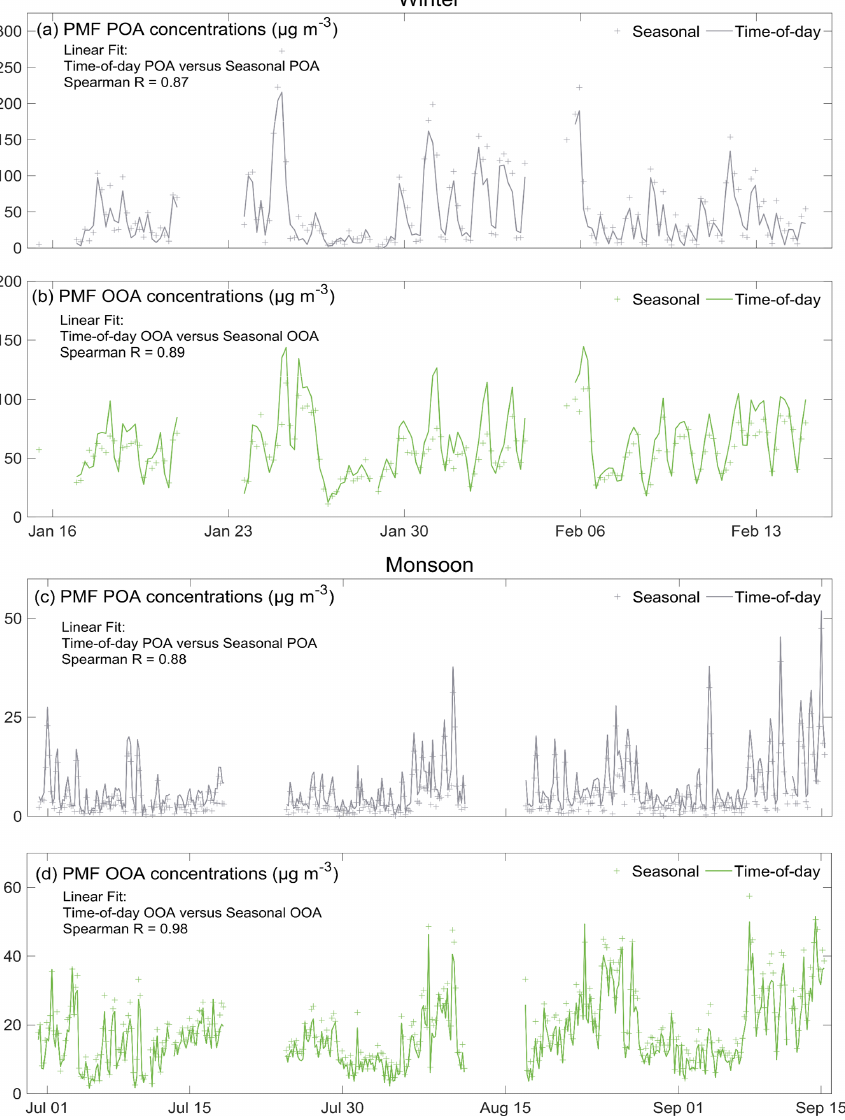
Figure 1. The 4h averaged concentration time series (TS) of time-of-day PMF (lines) and seasonal PMF ( + ) primary organic aerosol (POA) and oxygenated organic aerosol (OOA) factors in (a) – (b) winter 2017 and (c) – (d) the 2017 monsoon season (in µgm − 3 ). POA factor concentrations show stronger seasonal variations than